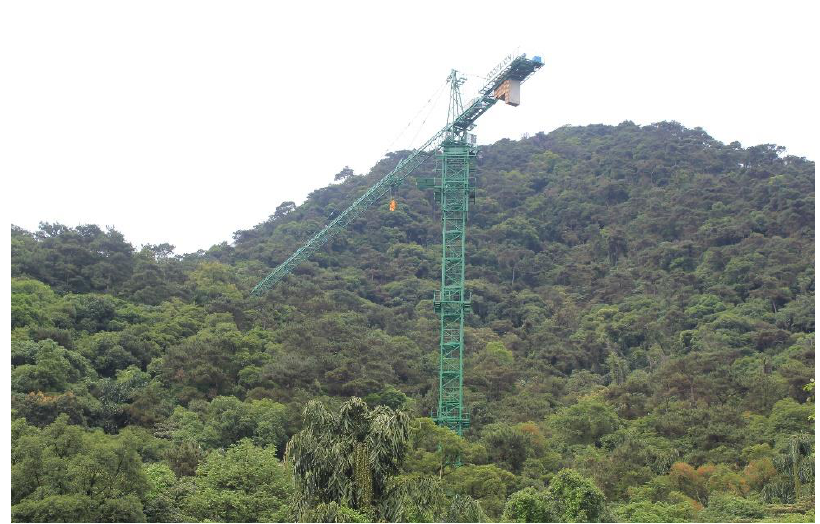
Figure 1. The vertical plot in the study, which centred on a 60 m high canopy crane with a 60 m long arm.